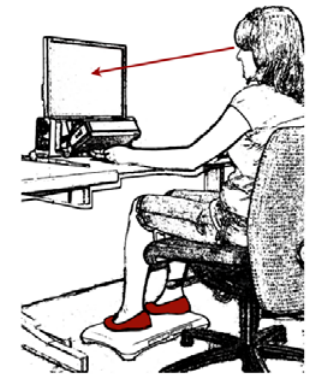
Figure 1. Envisioned setup for gaze- and foot-input in a desktop